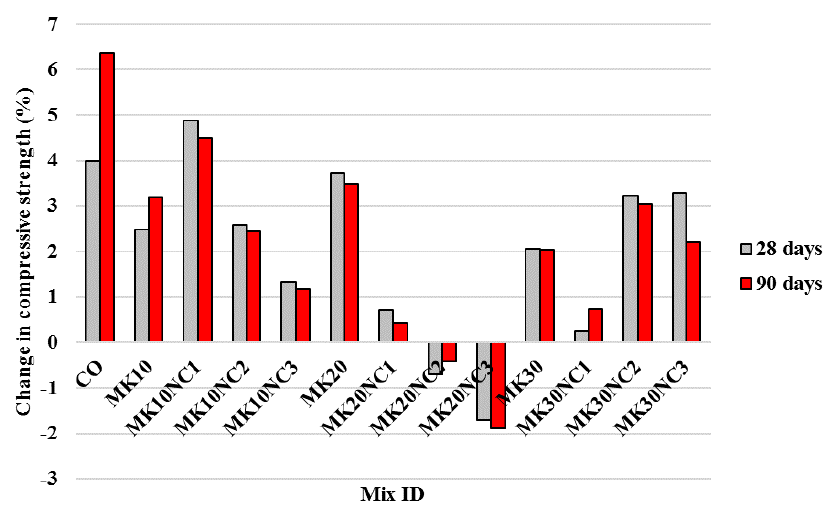
Figure 7. Percentage change in compressive strength of samples by the addition of fibres at 28 and 90 days with similar volumes of metakaolin and nano-CuO.